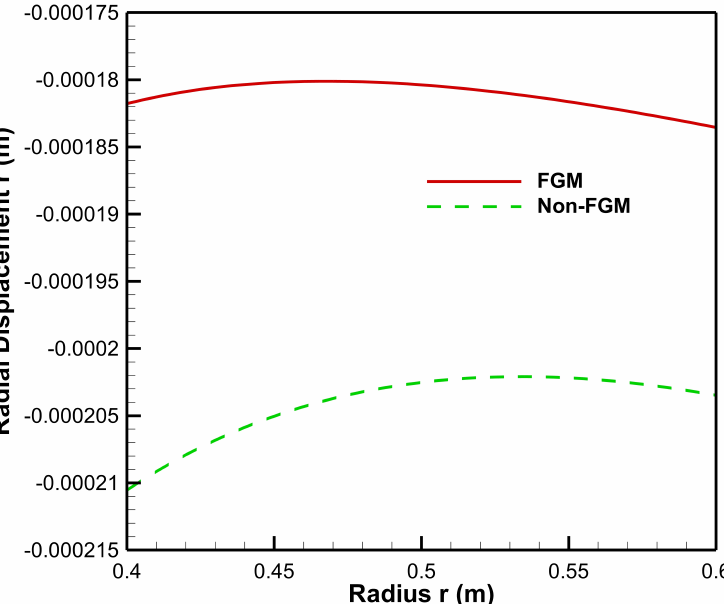
Figure 15. Displacement along the radius of the cylinder under internal pressure, P a = 20 MPa and external pressure, P b = 50 MPa.